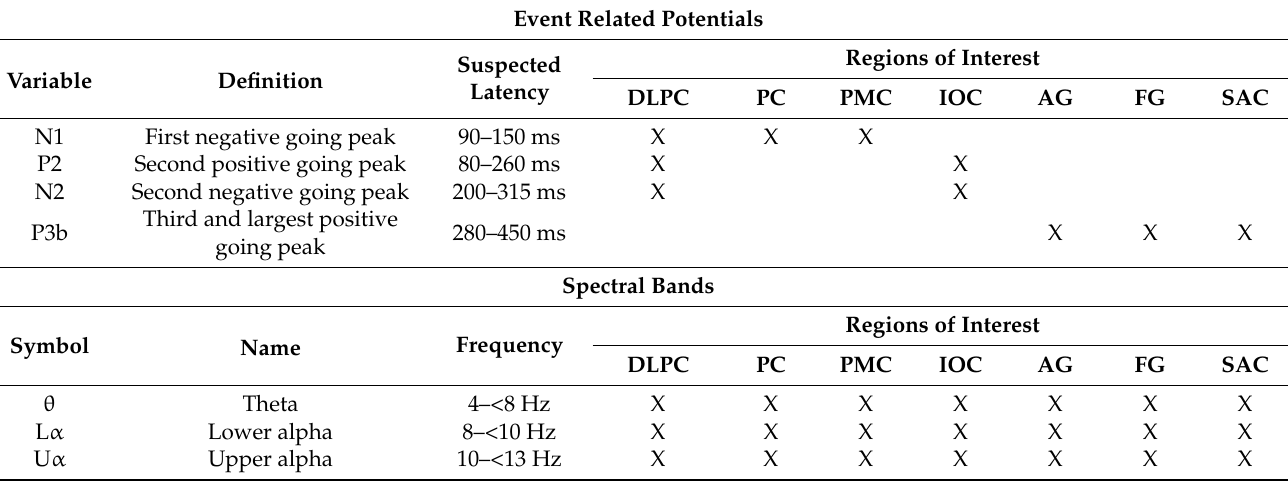
Table 1. Definitions, localisations and suspected latencies of Spectral power and ERPs of